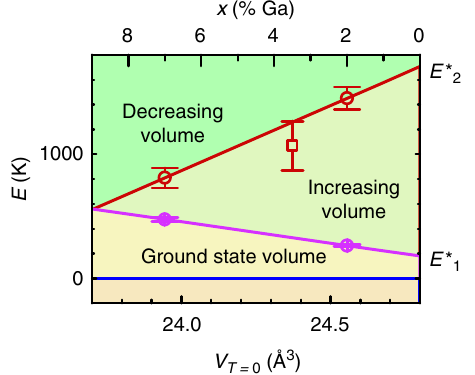
Fig. 3 Schematic energies and volumes of Pu. Excitation energies E (cid:1) 1 (magenta circles) and E (cid:1) (red circles) for δ -Pu 1 − x Ga x for x = 2 and 7% 2 (upper x axis) according to Table 1 (circles), with the lines of the same color indicating interpolations (or extrapolations for x = 0) assumed during fi tting (see Methods). The lower horizontal axis shows the approximate atomic volume V T = 0 of the ground state ( T = 0). Shaded regions illustrate the relative volume changes accompanying the excitations. The open square corresponds to the resonance energy observed in neutron scattering measurements 39 , where the error bar indicates its approximate